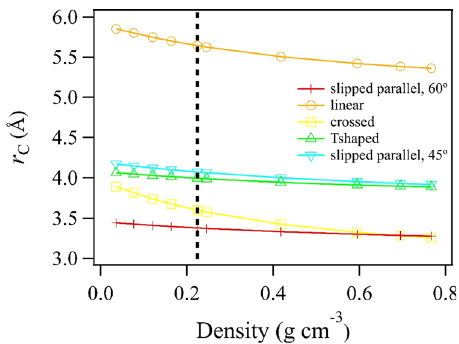
Fig. 8 Predicted critical radii for CO 2 dimer geometries. Critical interaction radii are shown at each experimental density for slipped parallel (both 60° and 45° orientations), linear, crossed, and T-shaped geometries described per the CO 2 dimer potential energy surface 51 . The black vertical line indicates a density of 0.224 g cm − 3 , where 1/ e of the vibrational structure inherent to the spectrum remains.